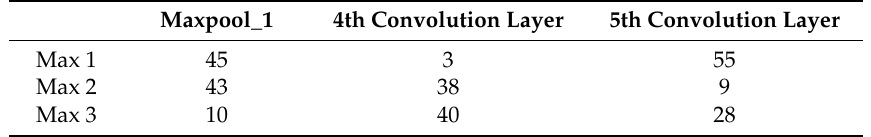
Table 2. Top-three maximum value features selected for each layer.